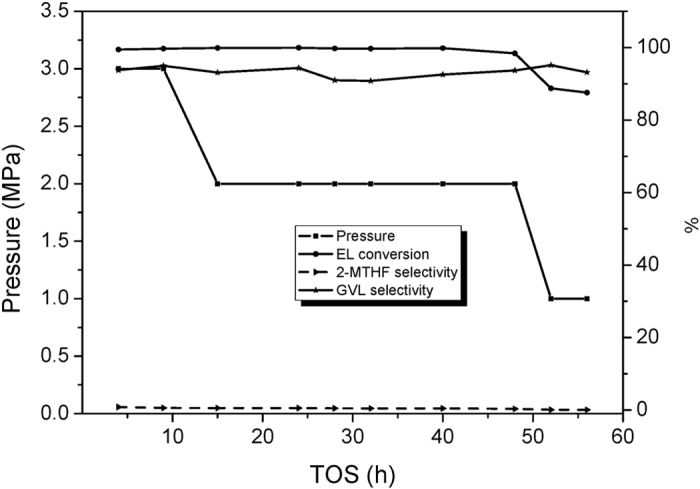
The effect of pressure on the Cu/Al2O3-SiO2 catalyst performance.